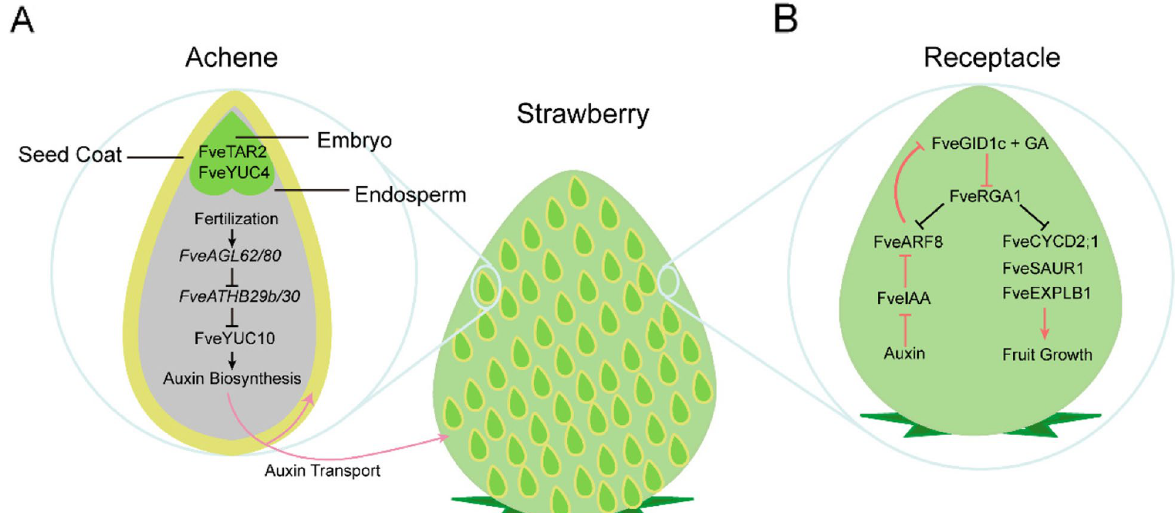
Fig. 3 Strawberry fruit structure and a model illustrating the regulatory pathway during fruit initiation and growth. A Double fertilization promotes biosynthesis of auxin and GA in the seed. Auxin and GA can stimulate receptacle development after being transported to the receptacle. B A diagram of receptacle illustrating the regulatory mechanism of fruit set. FveRGA1 is shown as a central player. The red lines indicate regulatory actions post-fertilization. Positive (arrows) or negative (bar) regulations are indicated. Adapted from (Feng et al. 2019; Zhou et al. 2021; Guo et al.